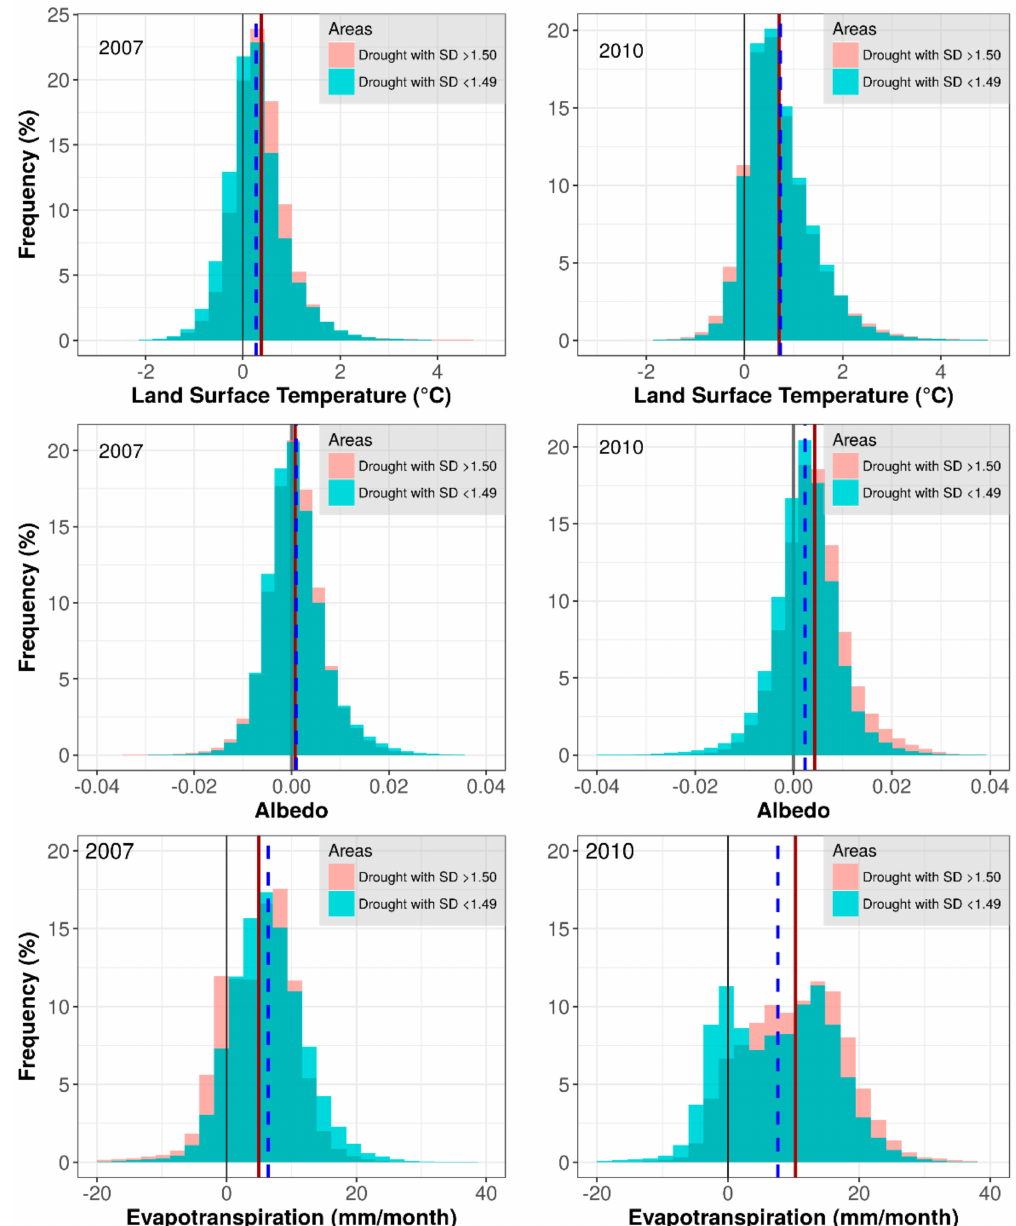
FigureA5. Histogramsoftheincreaseorreductioninthelandsurfacetemperature(top), albedo(middle), and evapotranspiration (bottom), for the areas with extreme conditions ( ≥ 1.50 SD or ≤ 1.49 SD) during the droughts of 2007 and 2010. The dotted lines (red = drought ≥ 1.50 SD, blue = drought ≤ 1.49 SD) represent the averages for each